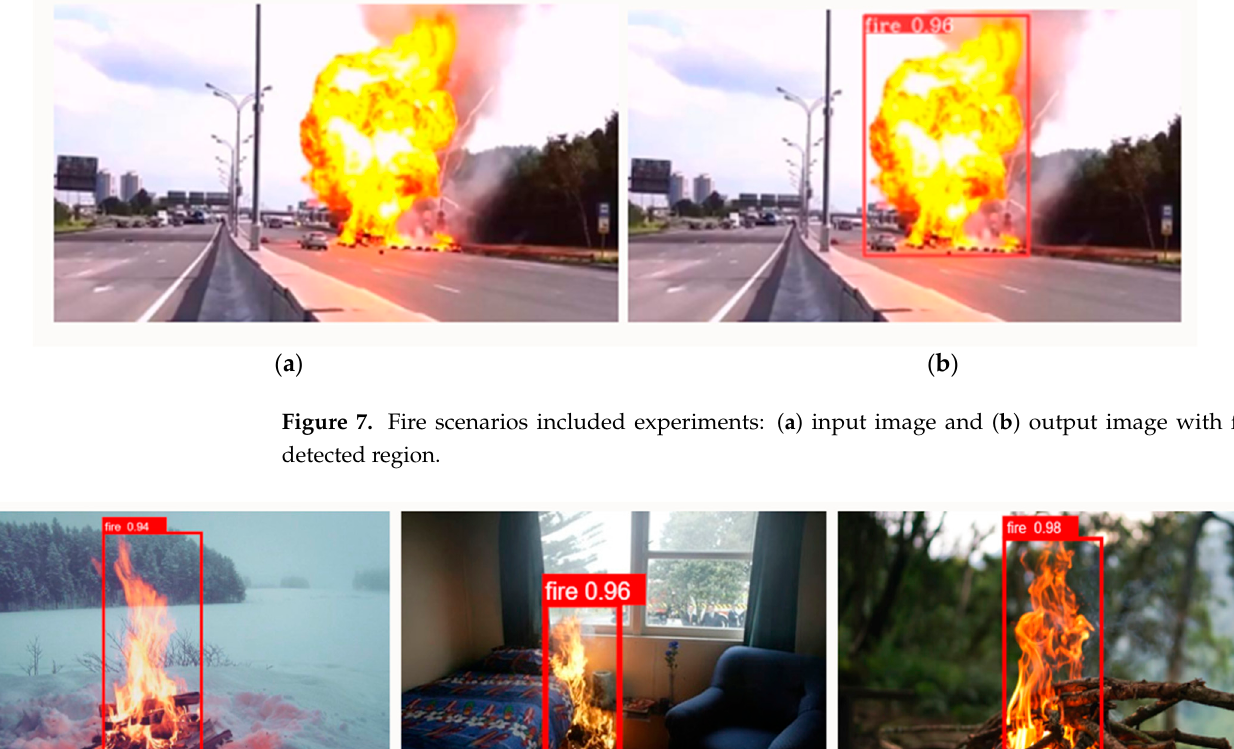
Figure 7. Fire scenarios included experiments: ( a ) input image and ( b ) output image with fi re de- tected region.